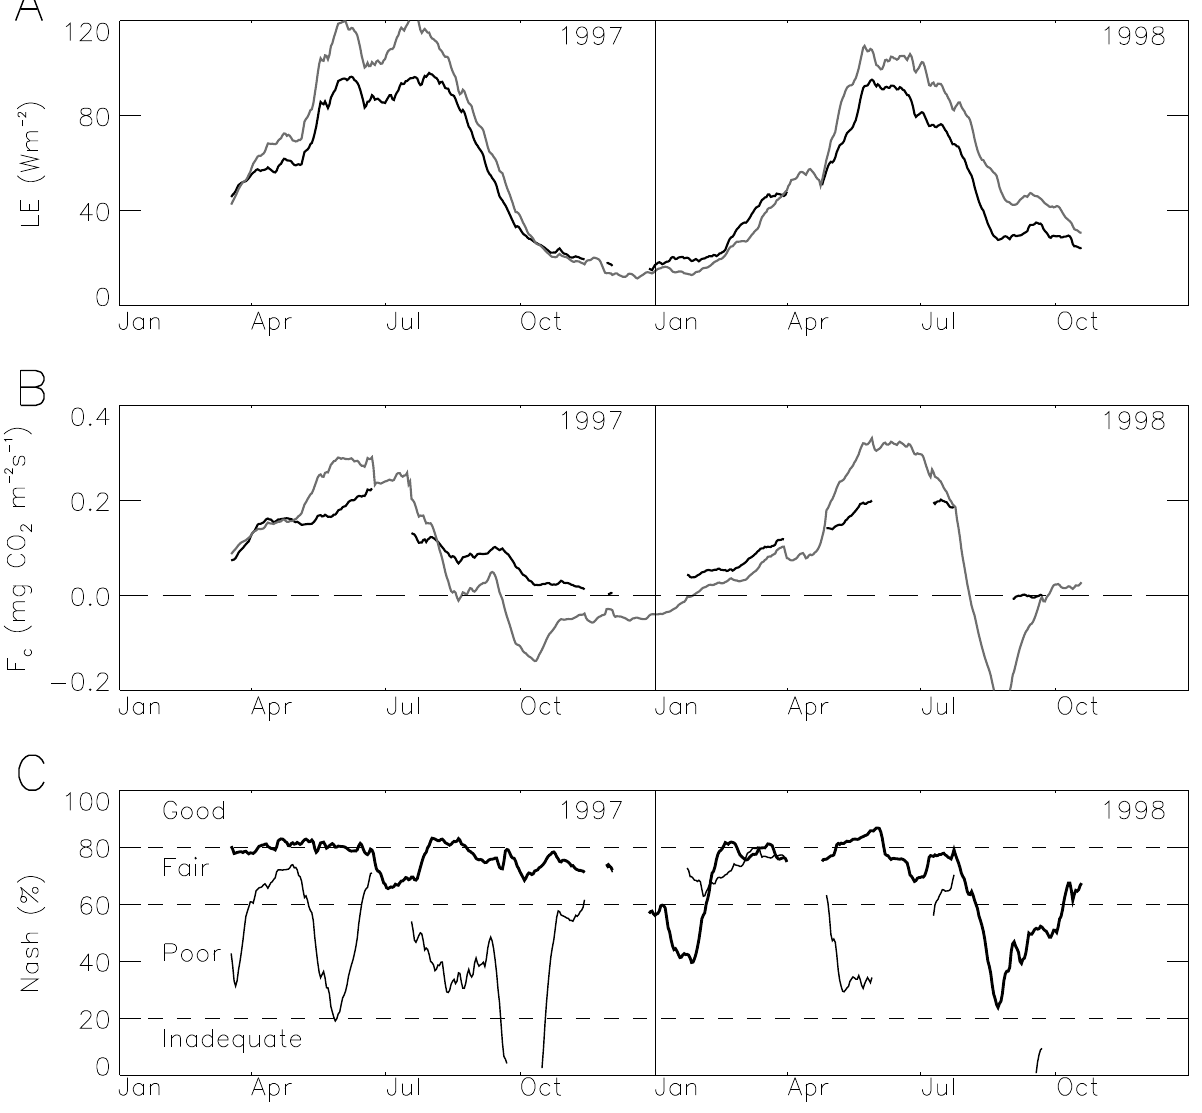
Fig. 4. Seasonal performance of the ISBA-A-g s model over the Le-Bray forest, in terms of (A, C) evapotranspiration and (B, C) net CO 2 flux: (A, B) comparison of simulations with eddy covariance measurements (grey and dark lines, respectively), (C) skill score (Nash criterium) for evapotranspiration and net CO 2 flux (thick and fine lines, respectively). The simulated CO 2 flux was obtained by using the ecosystem respiration of Berbigier et al., 2001. The flux and skill score values are smoothed using a 30-day moving average, in order to show the general